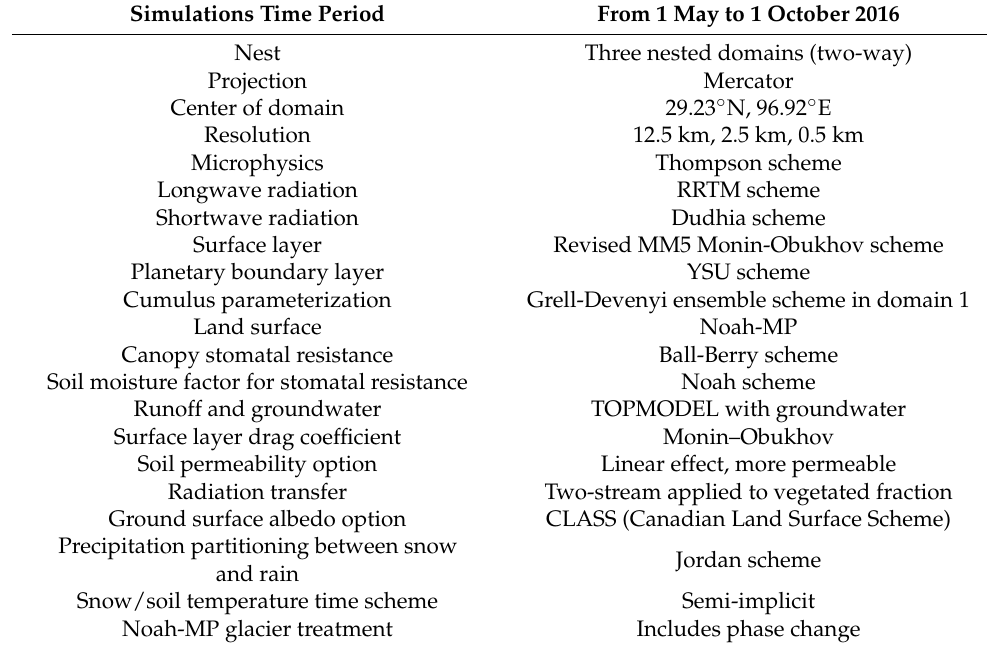
Table 1. Detailed options that were selected in WRF coupled with the Noah-MP